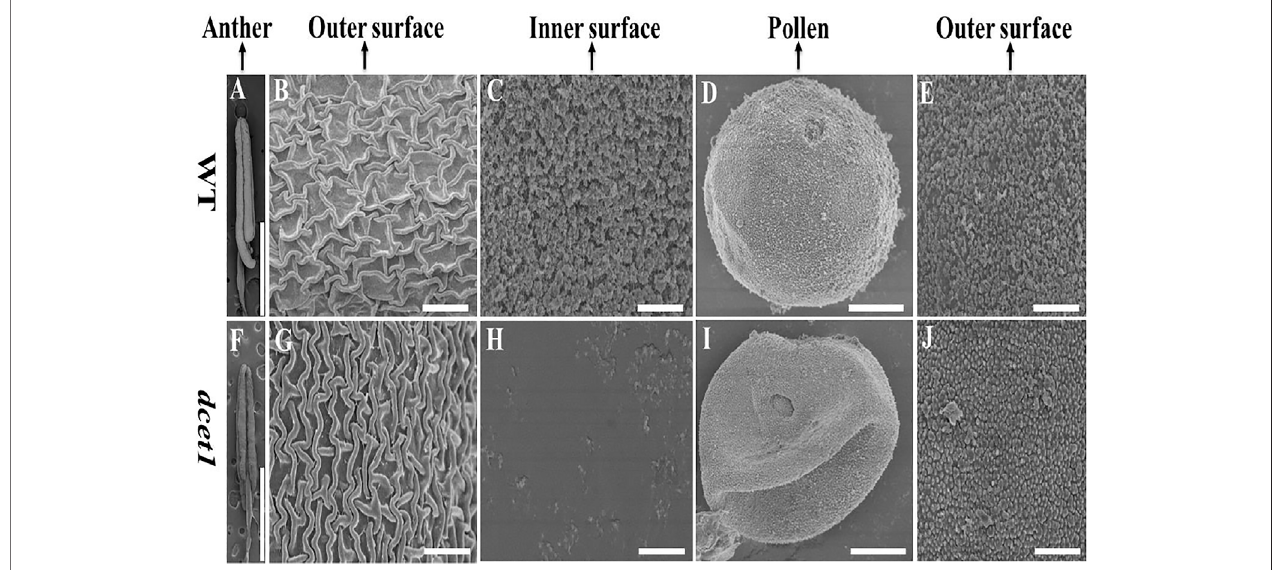
FIGURE 3 | Scanning electron microscopy (SEM) analysis of the surfaces of anthers and pollen grains in the wild-type (WT) and mutant ( dcet1 ) (A – E) Represents WT and (F – J) represents dcet1 . Scale bars (cid:1) 100 µm in (A,F) , 2 µm in (B,C,G,H,E,J) , and 1 µm in (D,I) .